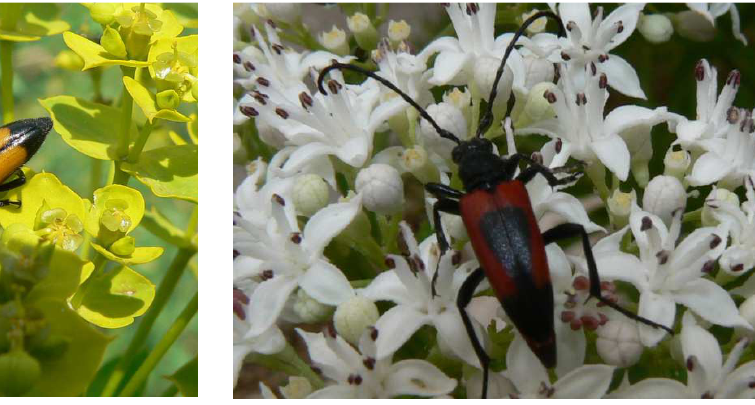
Figure 4. Stictoleptura cordigera (Füsslins, 1775) (photo: Milan Đ uri ć )